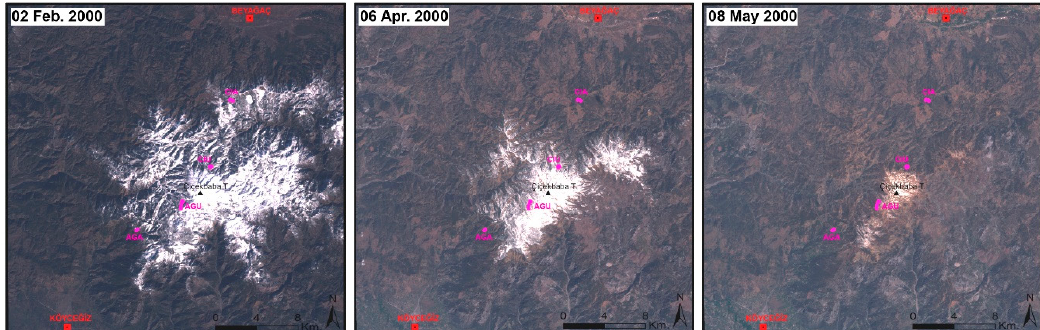
Figure 3. Areas covered with snow at di ff erent dates on Sandıras Mountain. Landsat TM imageries (321 band combination) [43]. Magenta areas correspond with the sampling sites. The red points at the upper and lower sides of the images indicate the settlement (city) centers (also see Figure 8).